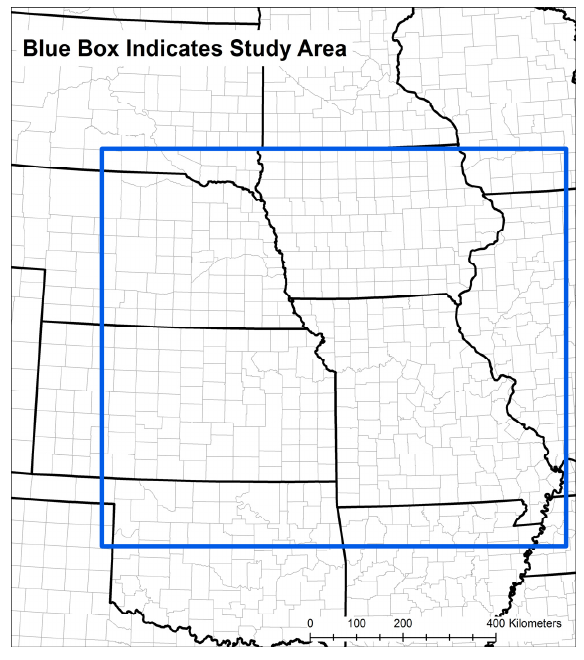
Figure 1. Map showing the study area for this project.